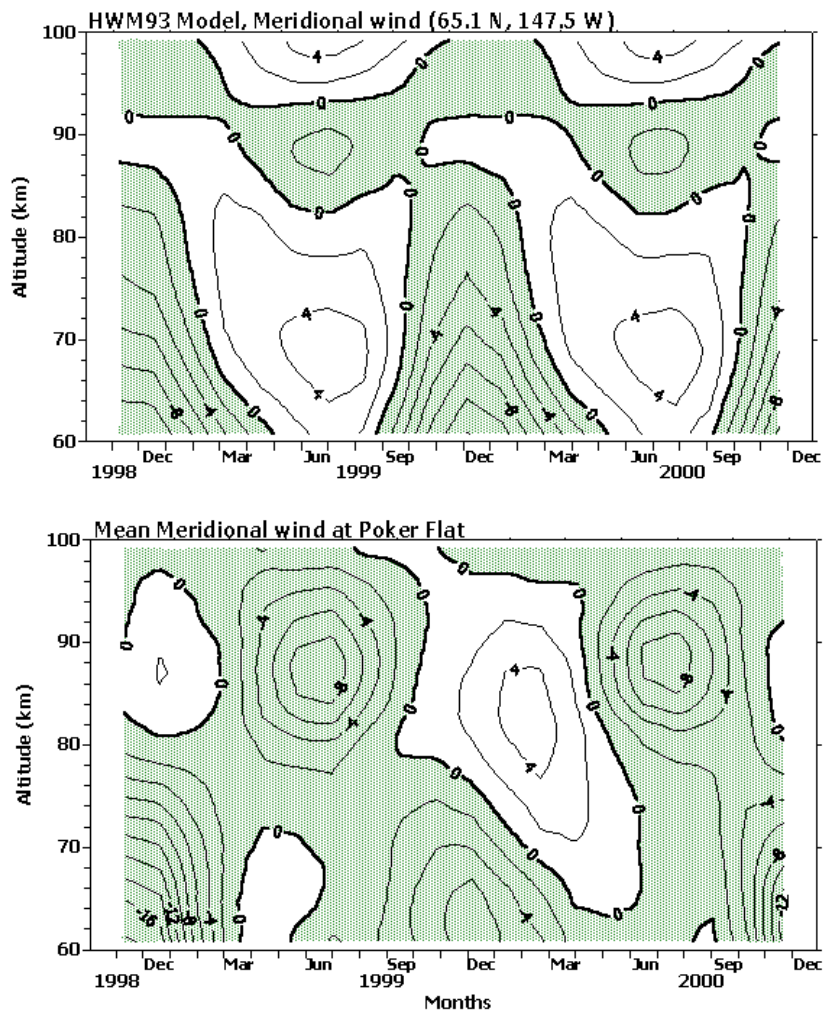
Fig. 3. As in Fig. 2 but for the merid- ional wind. Periods of equatorward mo- tions are denoted by shaded